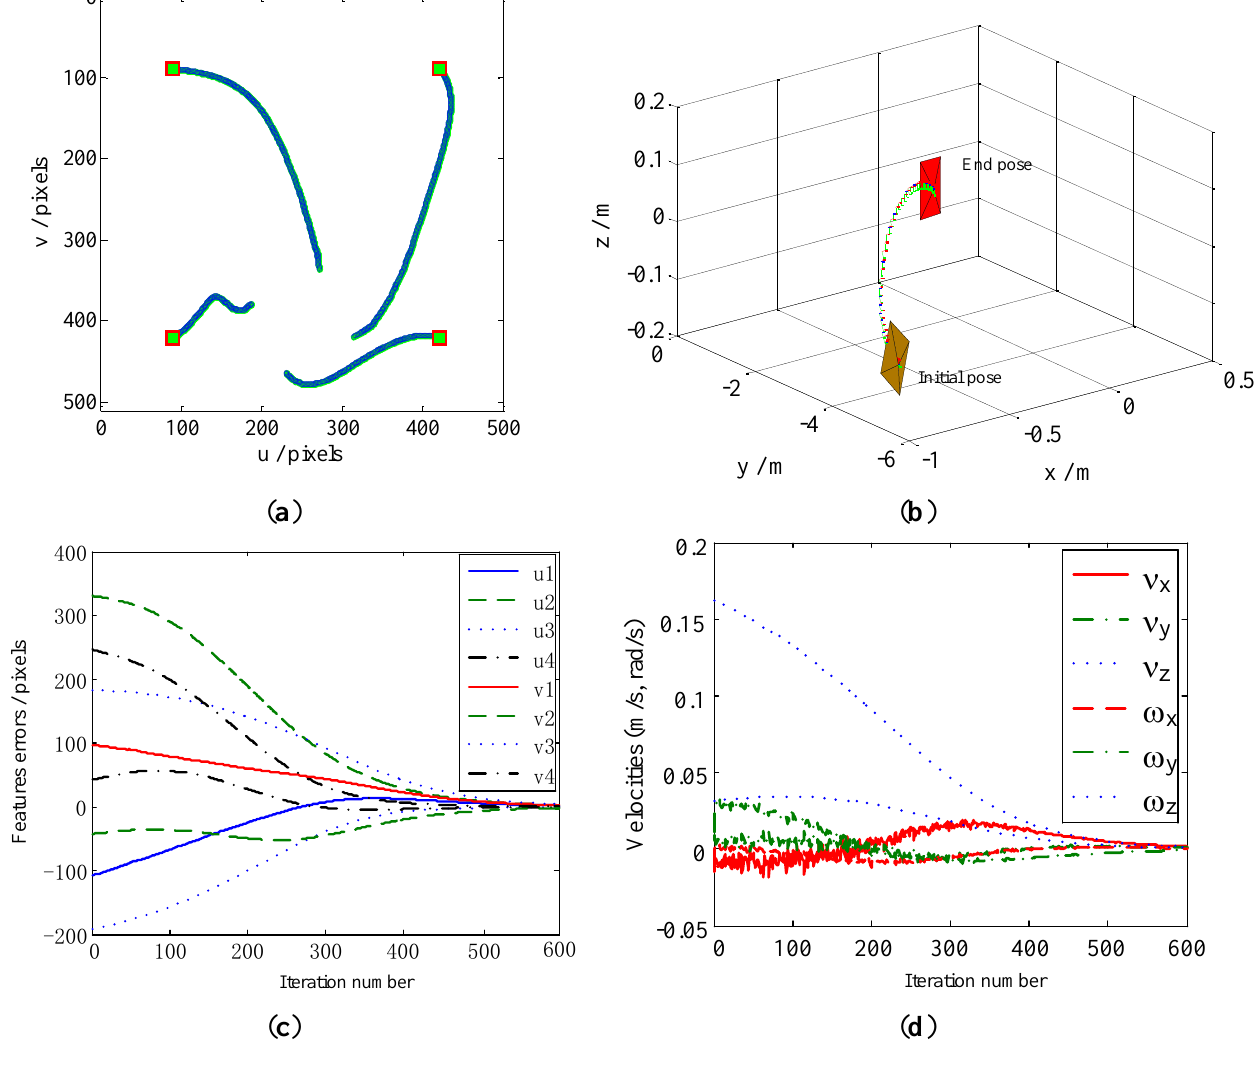
Figure 12. Results obtained by our method for Case 4. ( a ) Feature trajectories; ( b ) Camera trajectory; ( c ) Feature errors; ( d ) Camera